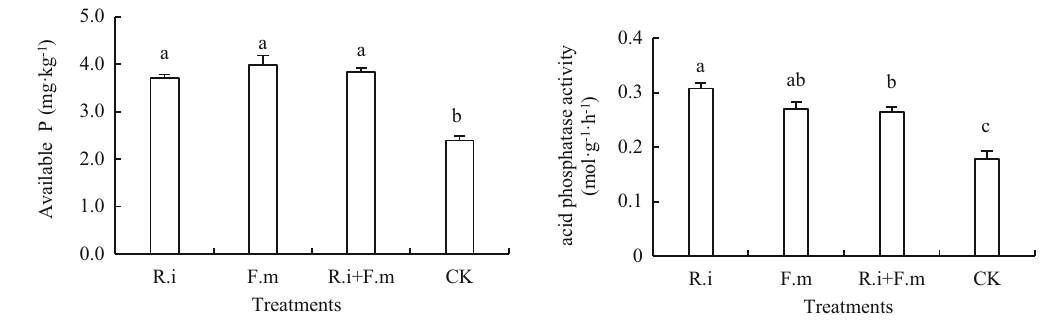
Fig. 5 Effect of AM inoculation on soil acid phosphatase and available phosphorus of Amygdalus pedunculata Pall.